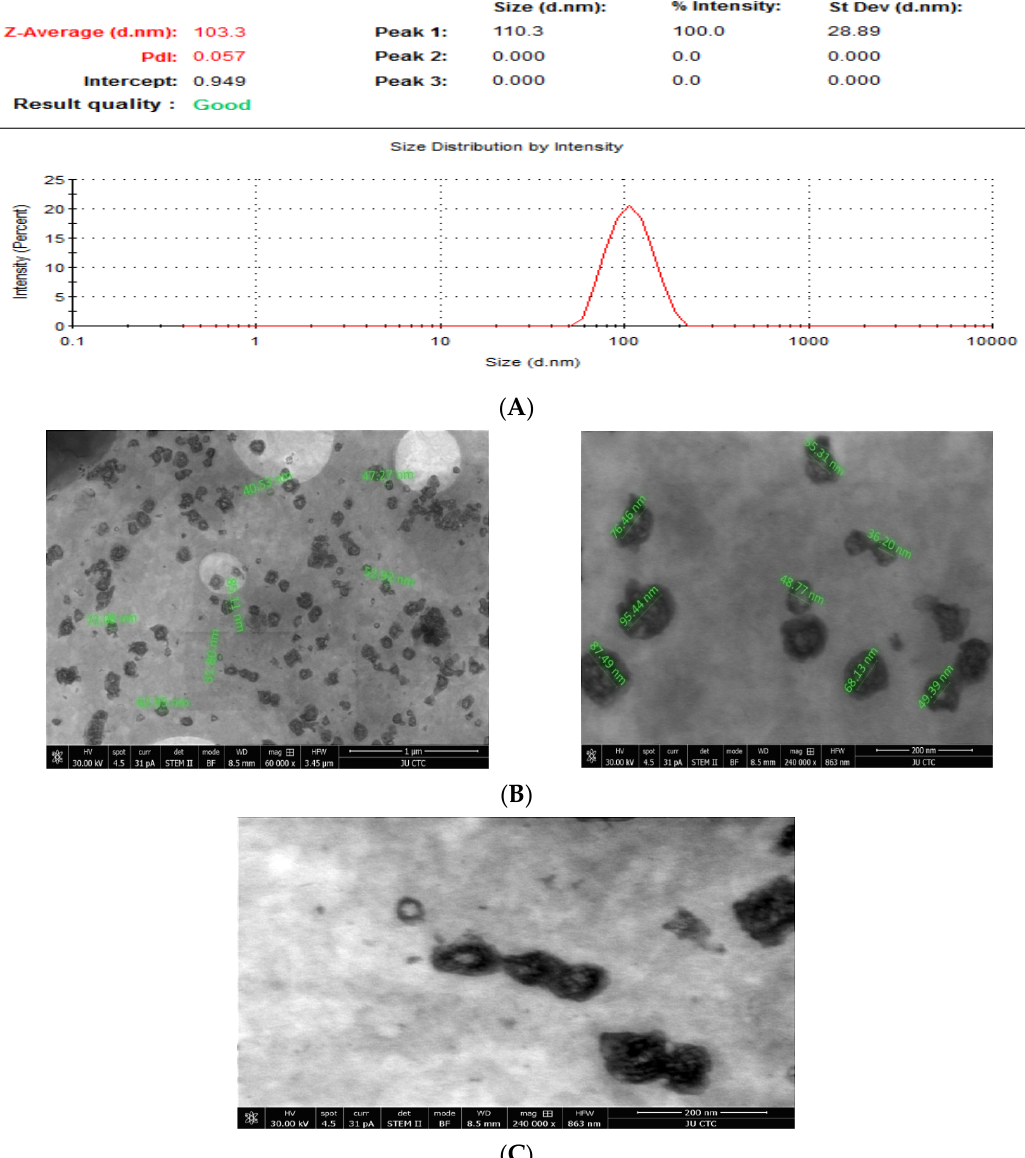
Figure 2. ( A ) Size distribution of CAP-loaded nanoliposomes by DLS; ( B ) TEM Shape and Size (CAP-loaded nanoliposomes); ( C ) Morphology (CAP-loaded nanoliposomes).